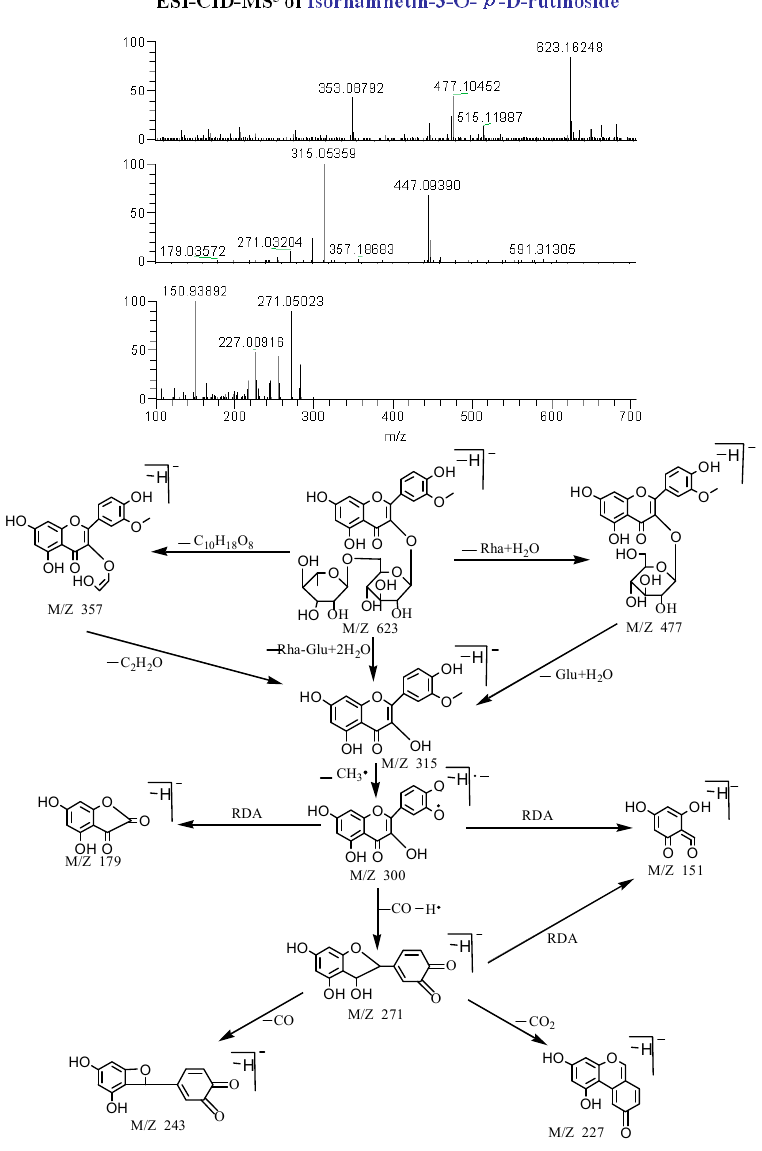
Figure 2. ESI-CID-MS 3 spectra and proposed fragmentations for isorhamnetin-3- O - β - D -rutinoside ( 53 ) from WZYZW.